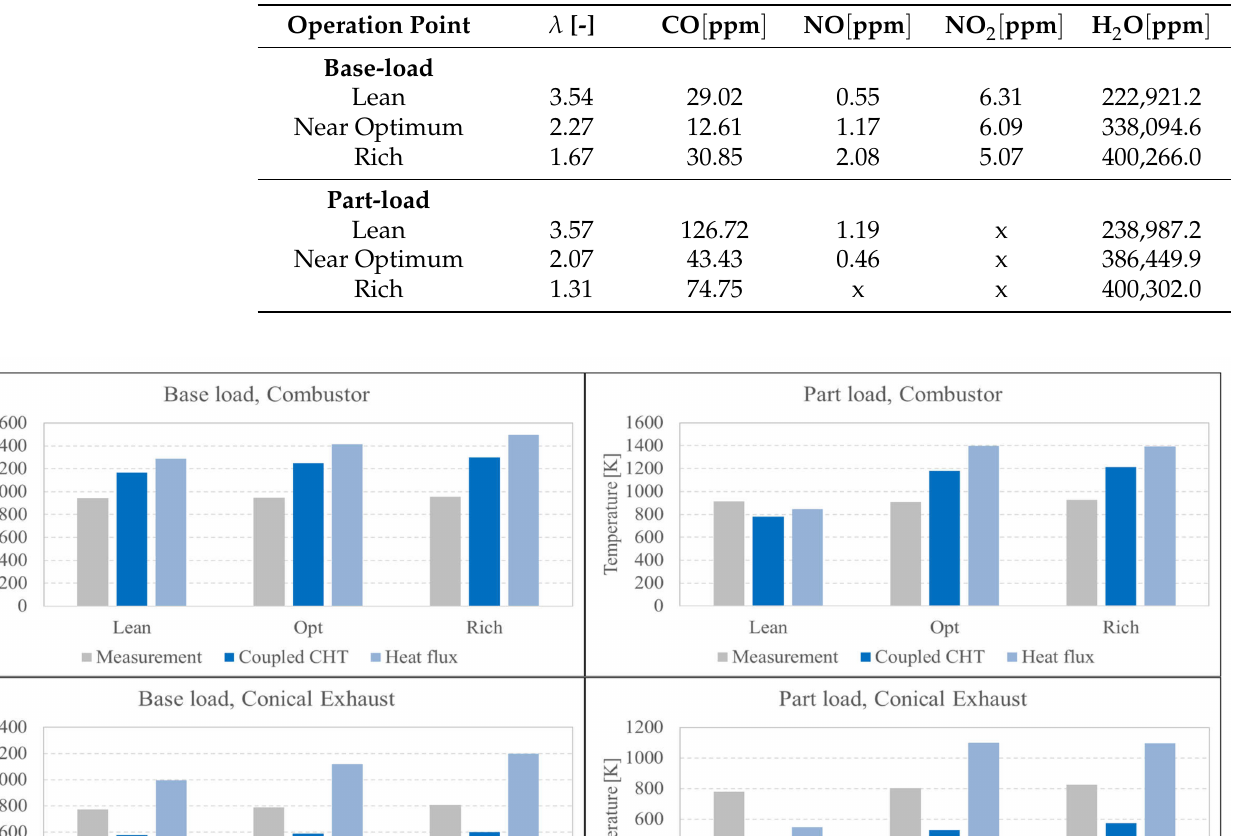
Table 2. Experimental results of emissions measurements. x: no sensible value obtainable. ppm values unreferenced to oxygen content. Measurement uncertainties in Table 3. Measurement standard deviation: ± 0.1 ppm.